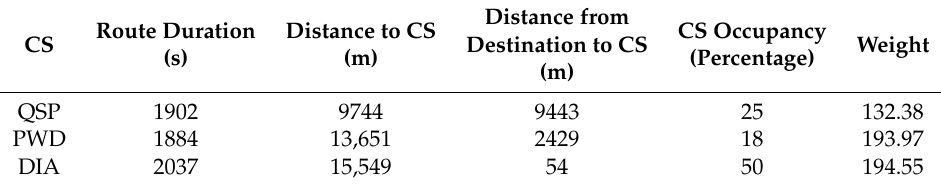
Table 5. Decision algorithms heuristics results for the Nissan Leaf